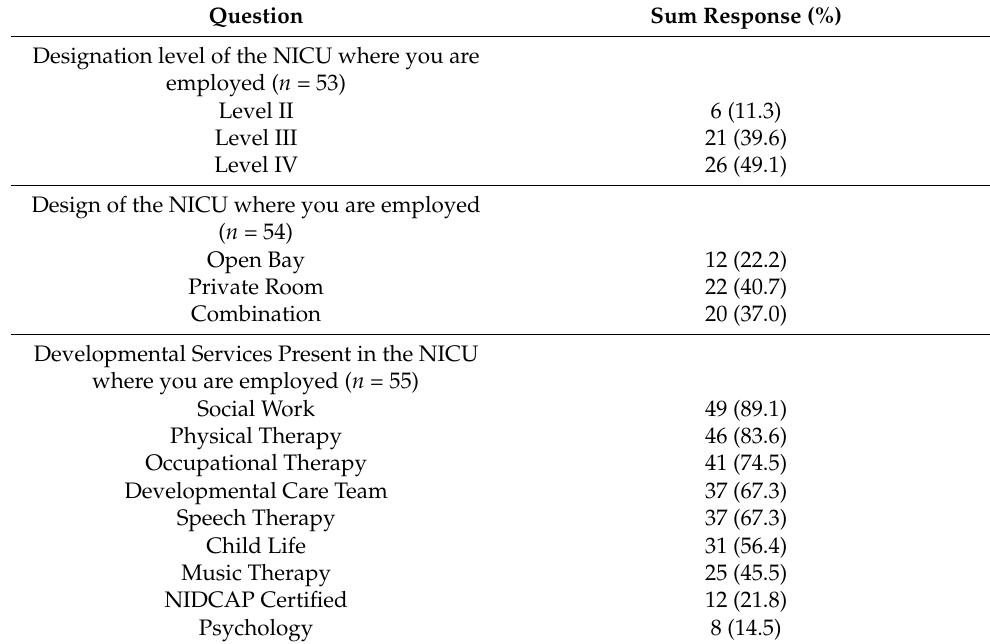
Table 2. Description of reported unit characteristics.